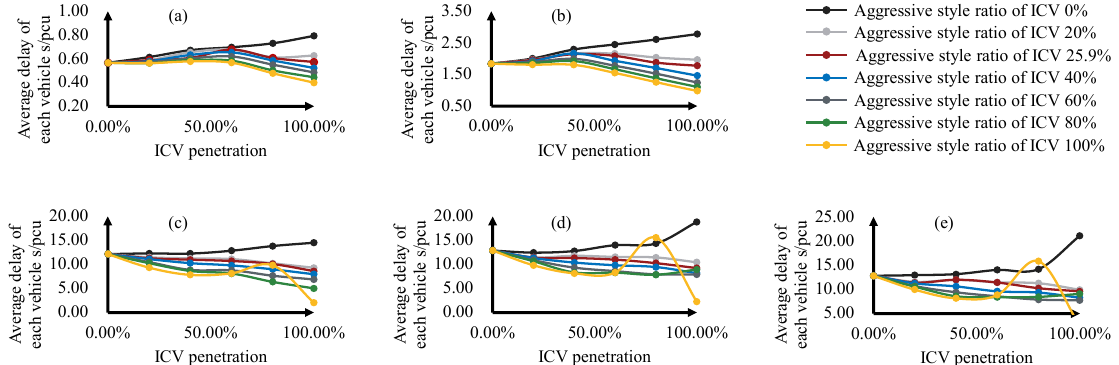
Figure 5. The impacts of SLADS on traffic delay on the secondary motorways under different driving styles with the volume input being equal to the first service level ( a ), the third service level ( b ), the saturated service level ( c ), the 20% ( d ) and 40% ( e ) oversaturated service level.